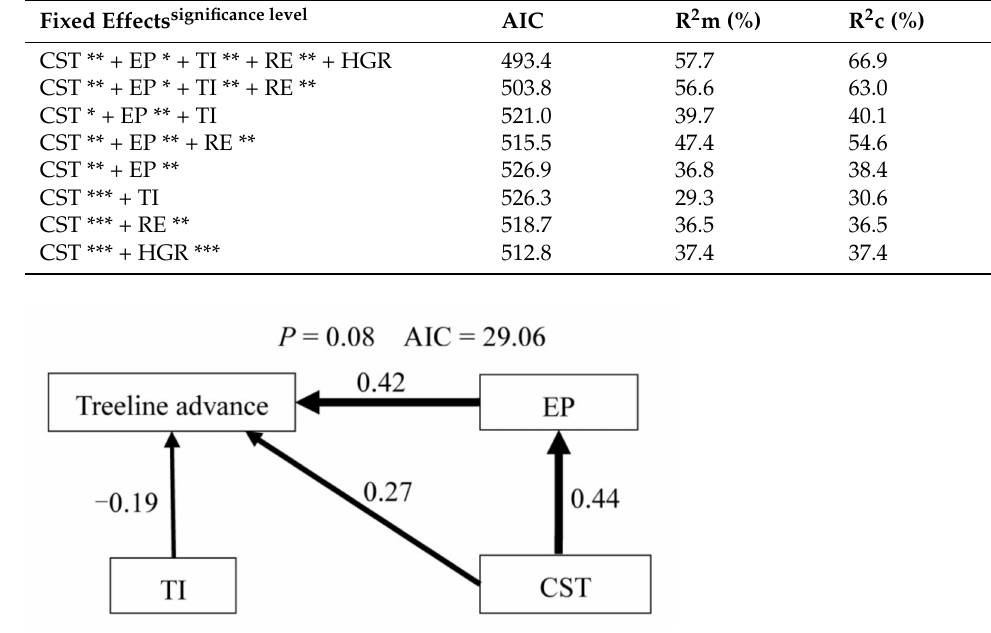
Figure 4. Structural equation model showing the direct and indirect effects of three key predictor variables (i.e., CST, EP and TI) on treeline advance of TP. The importance of the predictor variables is indicated by the width of the arrow